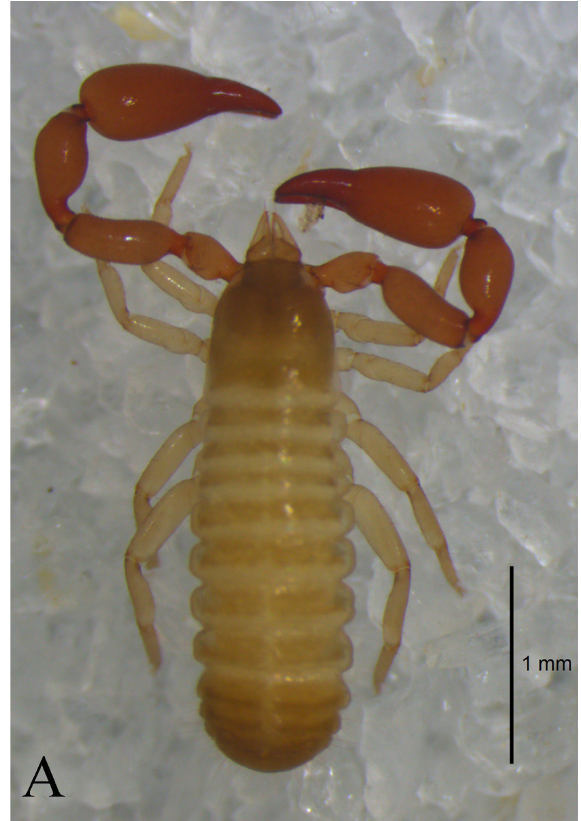
Image 1. Atemnus politus : female habitus, dorsal